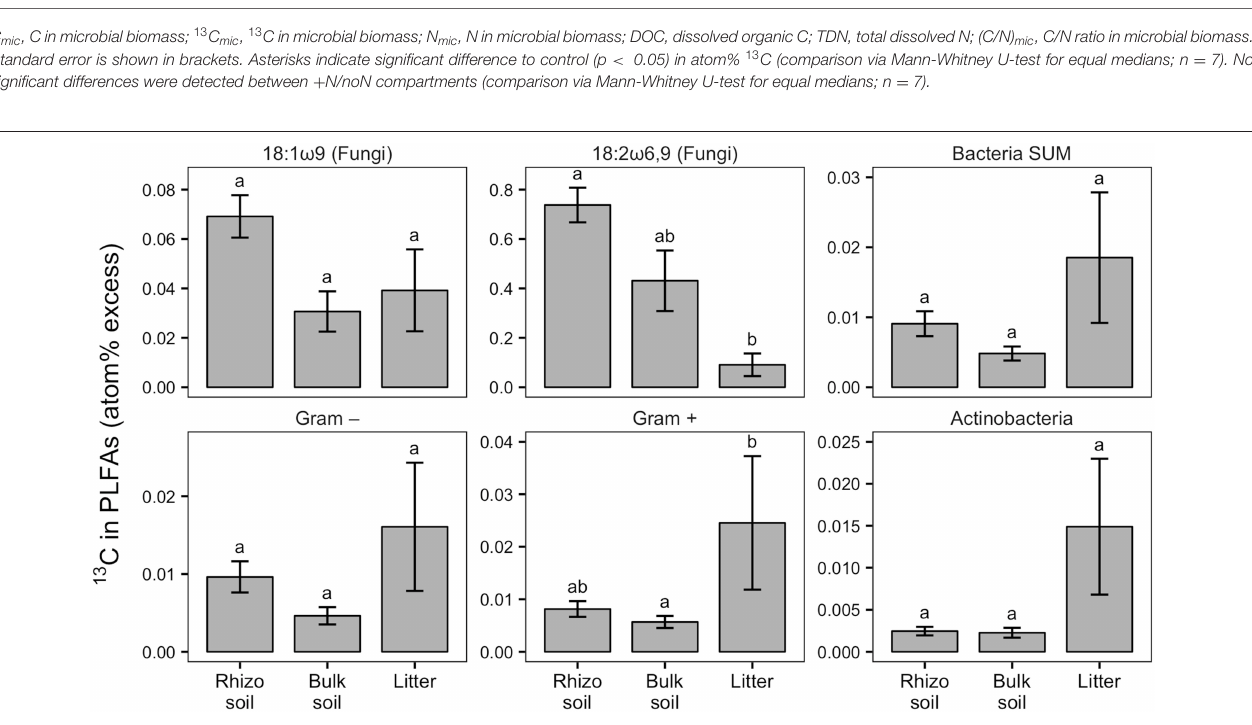
FIGURE 4 | Relative enrichment of 13 C in fungal-specific (18:1 ω 9 and 18:2 ω 6,9) and bacteria-specific PLFAs in rhizosphere, bulk soil, and litter pools shown as atom% excess 13 C (calculated by subtracting the natural abundance atom% value of the respective PLFA biomarkers). Bars show the weighted mean of each pool from N-treated and untreated sides from dual-labeled ( 13 C and 15 N) plant boxes. This format was chosen to emphasize general trends of relative 13 C enrichment in fungal and bacterial groups across the different pools irrespective of N addition. No significant differences in atom% excess 13 C could be detected between the N-treated and the untreated sides ( + N/noN; Mann-Whitney U -test for paired samples). For visualization of differences between + N/noN box sides see Figure S5 . Litter compartment enrichment indicates allocation of 13 C via ECM hyphae to root-distant bacteria. Error bars represent the standard error; n = 6. Differences in pools were analyzed with the Kruskal-Wallis rank sum test. Significant tests ( p < 0.05) were followed by Dunn’s post-hoc test of multiple comparisons with Bonferroni correction (adj. p < 0.05); significant differences are indicated by lowercase letters. All microbial groups were significantly enriched in 13 C in all pools, except for 18:2 ω 6,9, Gram-negative bacteria and Actinobacteria, each in bulk soil (comparison of atom% 13 C values via Mann-Whitney U -test, p < 0.05; not